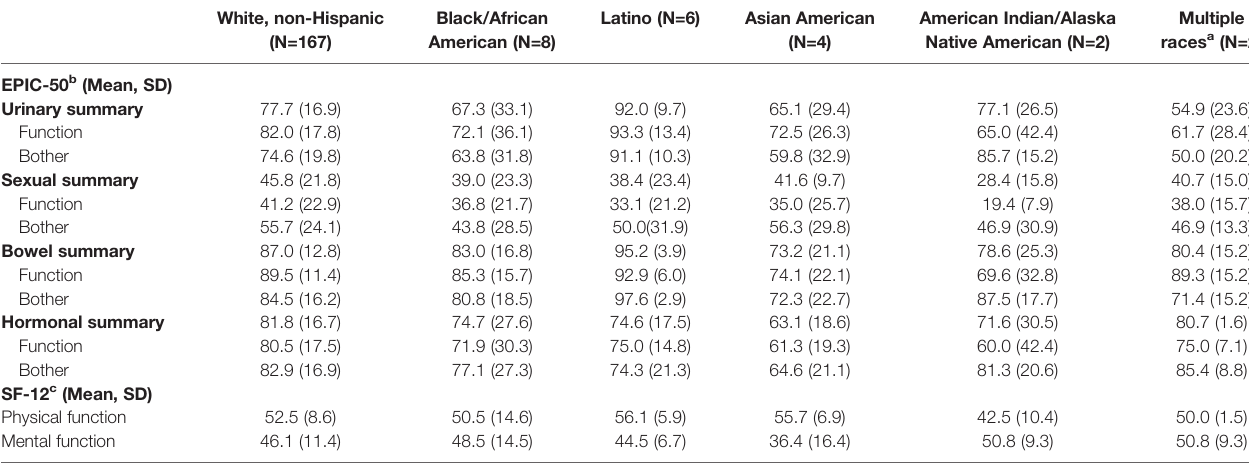
American Indian/Alaska Multiple Native American (N=2) races a (N=2)